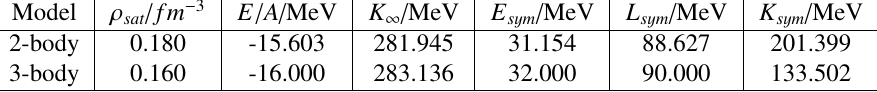
Table 1. Properties of the DDRH equation of state of in fi nite symmetric nuclear matter, obtained with 2–body interactions only ( fi rst row) and by adding 3–body interactions (second row).